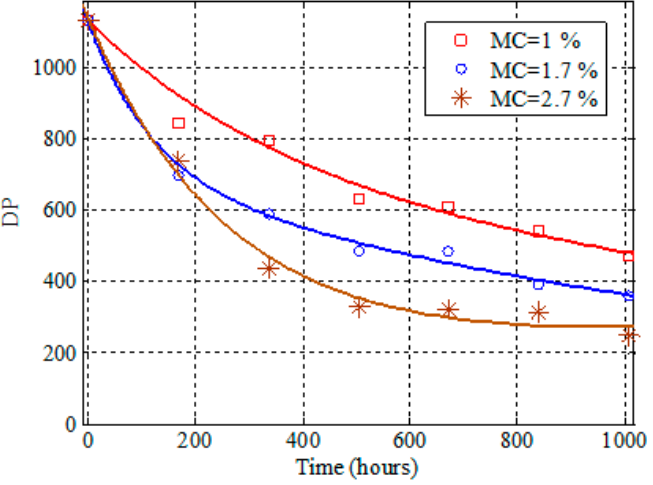
Figure 5. Ageing process at a temperature of 130°C of MO-immersed paper samples as a function of moisture. Fully described in [7]. Reprint with permission, Copyright 2017, IEEE.